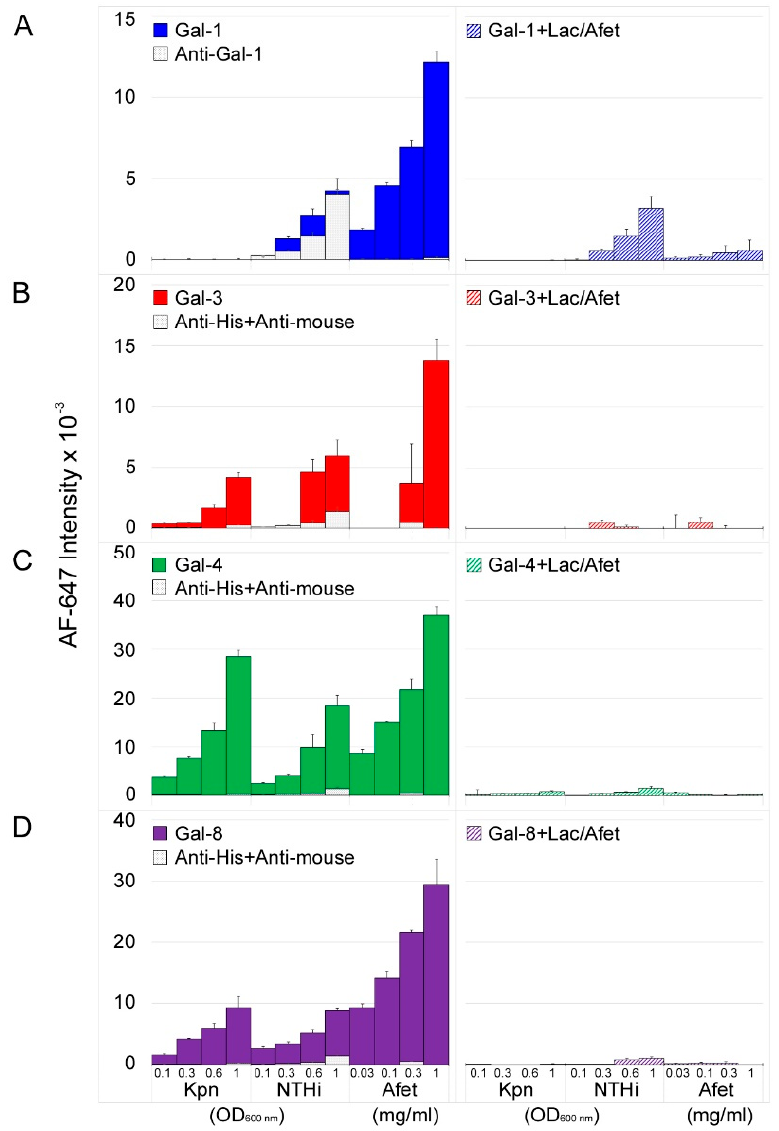
Figure 1. Galectin binding to Kpn and NTHi cells. Wild type bacterial cells were printed as triplicates at OD 600 of 0.1, 0.3, 0.6, and 1 onto nitrocellulose-coated single-pad glass slides, using a manual arraying system. The pan-galectin ligand asialofetuin (Afet) was similarly printed at 0.03, 0.1, 0.3, and 1 mg/mL. The binding of galectins in the absence (left panel, solid columns) or presence of 75 mM lactose plus 1 mg/mL asialofetuin in solution (right panel, dashed columns) was assessed by incubation with biotinylated anti-Gal-1 or with mouse anti-poly-His antibody pre-complexed with biotinyl- ated anti-mouse IgG, followed by incubation with AF647-streptavidin as final step. Blank experiments with antibodies in the absence of galectins were run in parallel (left panels, light grey columns). Data shown correspond to the mean of three different determinations and error bars indicate the standard deviation of the mean. From top to bottom, Gal-1 ( A ), Gal-3 ( B ), Gal-4 ( C ), and Gal-8 ( D